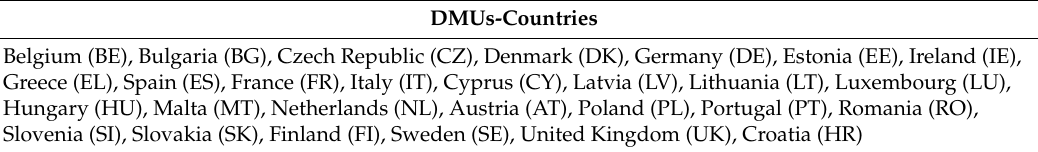
Table 2. EU countries and abbreviations.